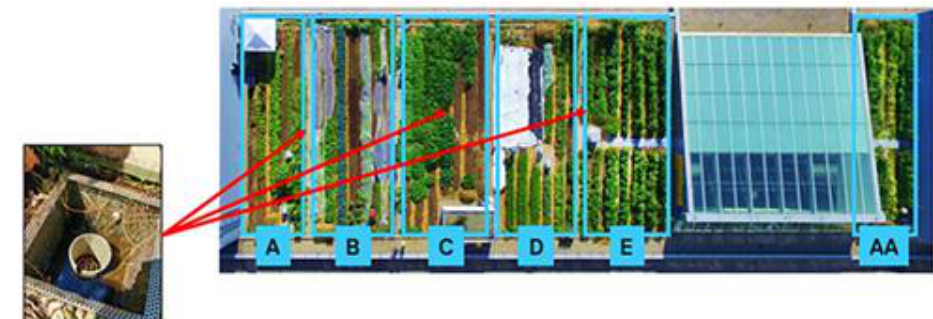
Figure 1. Areal field map of UFLL showing the zones and the beds.